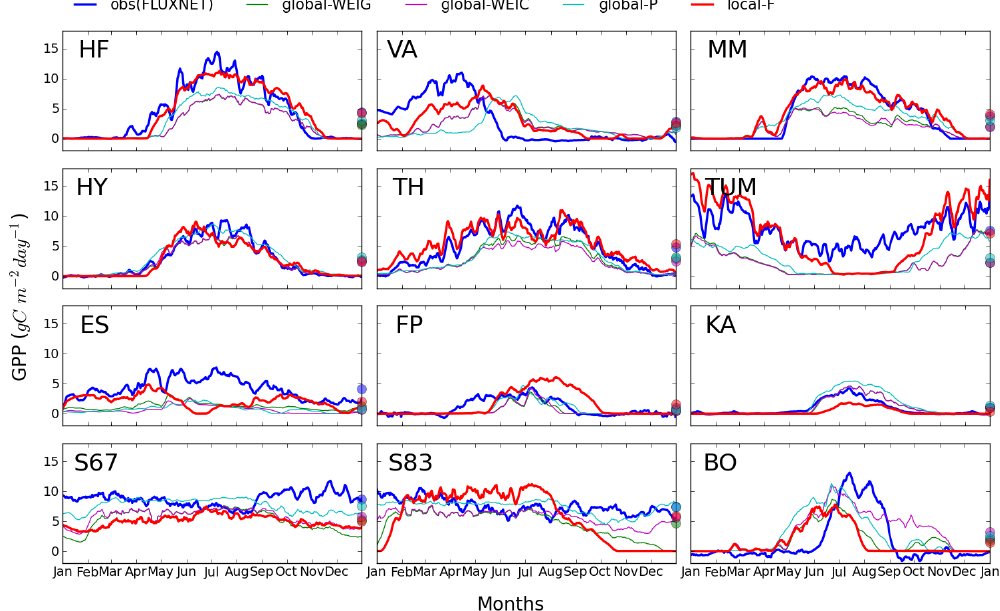
Figure 1. Seasonal cycle of model-predicted (local-F, global-WEIG, global-WEIC and global-P in Table 3) and observed GPP fluxes, smoothed with a 7-day moving average window, at the 12 FLUXNET sites (HF: Harvard Forest; VA: Vaira Ranch; MM: Morgan Monroe; HY: Hyytiala; TH: Tharandt; TUM: Tumbarumba: ES: El Saler; FP: Fort Peck; KA: Kaamanen; S67: Santarem Km67; S83: Santarem Km83; BO: Bondville). Model simulation years are given in Table 2. The thick lines refer to FLUXNET observations (blue) and simulated GPP from local-F model simulations (red). Annual averages for model simulations and observations are plotted as thick dots on the right of each plot in the same